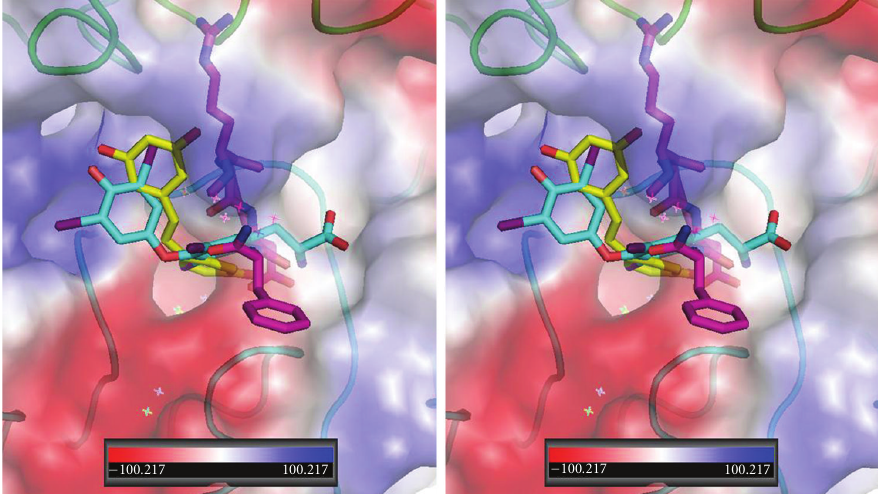
Figure 13: Stereoview of QM/MM model for T 4 (cyan, Ca1), trans -resveratrol (yellow, Ca1), and RGD peptapeptide (violet) bound in α v β 3 integrin at the RGD binding site. The electrostatic surface for integrin is shown. Red is negative and blue is positive surface. α v domain is green and β 3 domain is cyan. Figure drawn with